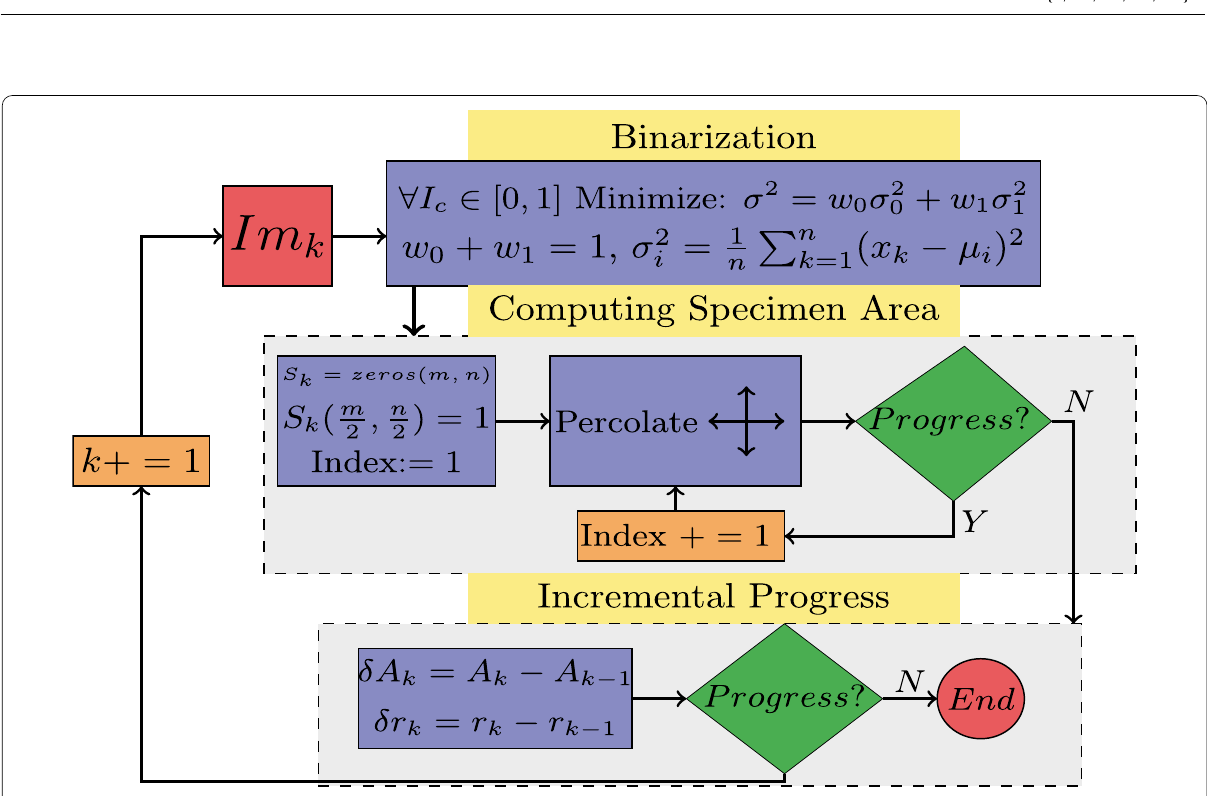
Fig. 1 Pseudo-chart of the computational